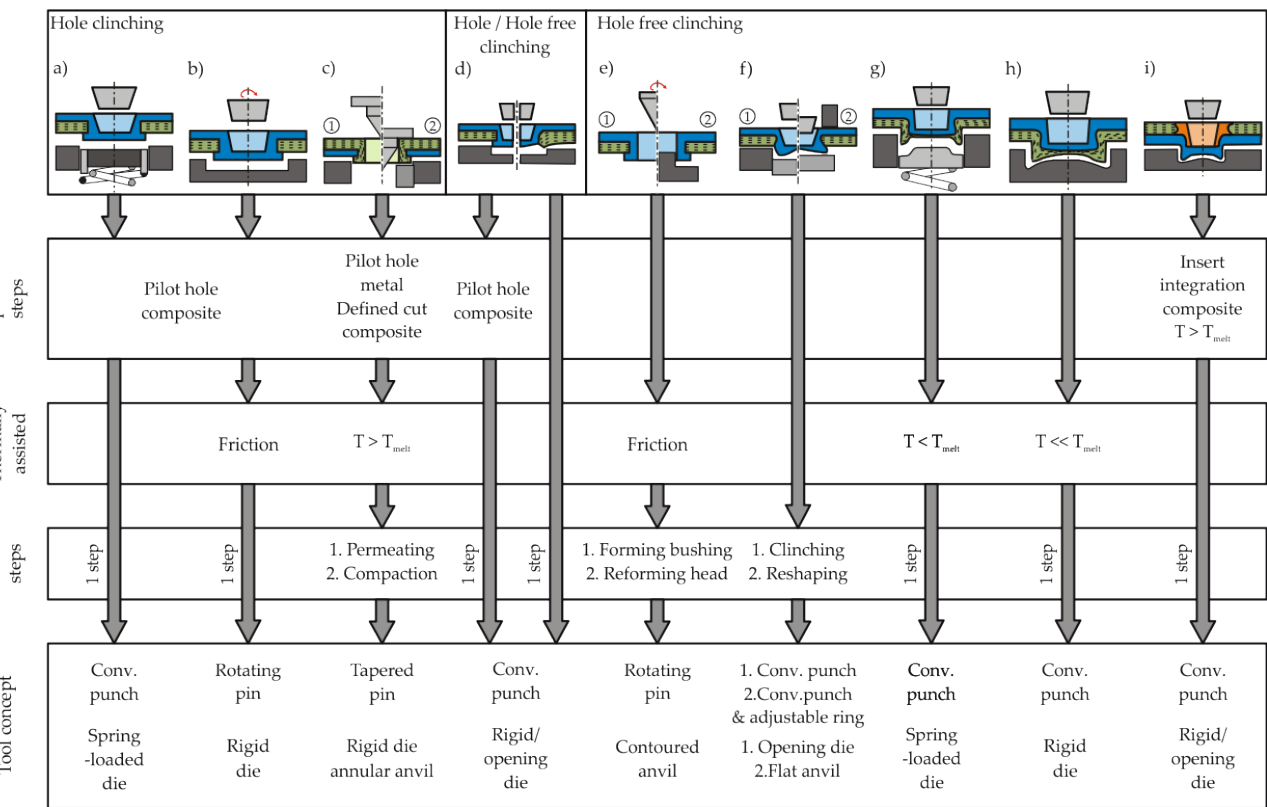
Figure 2. Classification of clinching processes: ( a ) Improved hole clinching [8], ( b ) Friction assisted Clinching [9], ( c ) Thermoclinching [16], ( d ) hole [6]/hole free [11,12] clinching, ( e ) Flow Drill Joining [15], ( f ) Two-Step Clinching [13], ( g ) Hotclinching [17], ( h ) Preheated Clinching [14], ( i ) Insert